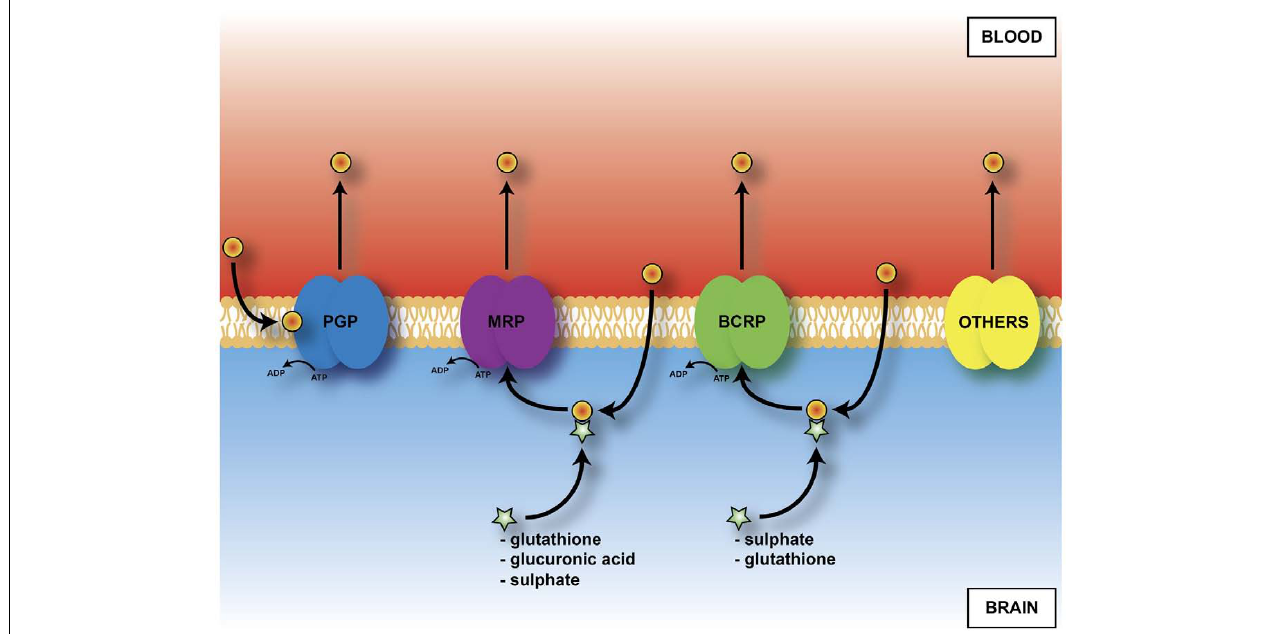
FIGURE 7 | Diagram of main outward transporters in cerebral endothelial cells. Some, e.g., PGP, (P-glycoprotein) prevent entry. For others, e.g., MRP